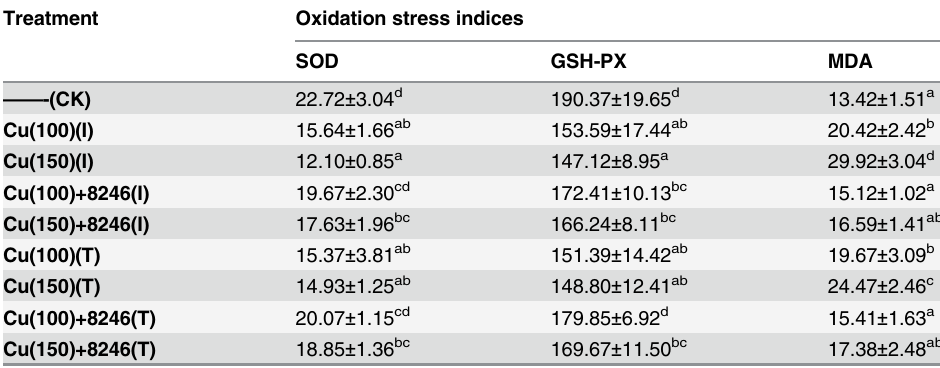
Table 7. Effects of CCFM8246 treatment on the activity of SOD, GSH-PX and level of MDA in the kid- neys of mice.